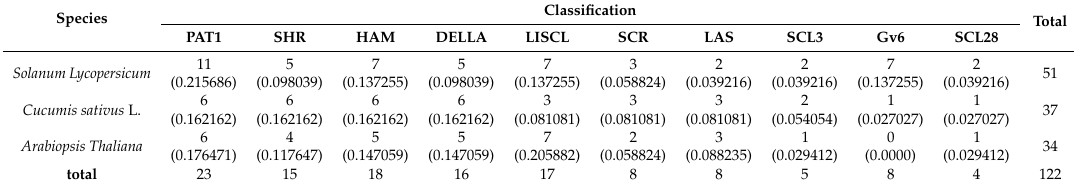
Table 1. Comparison of GRAS transcription factors among di ff erent species.